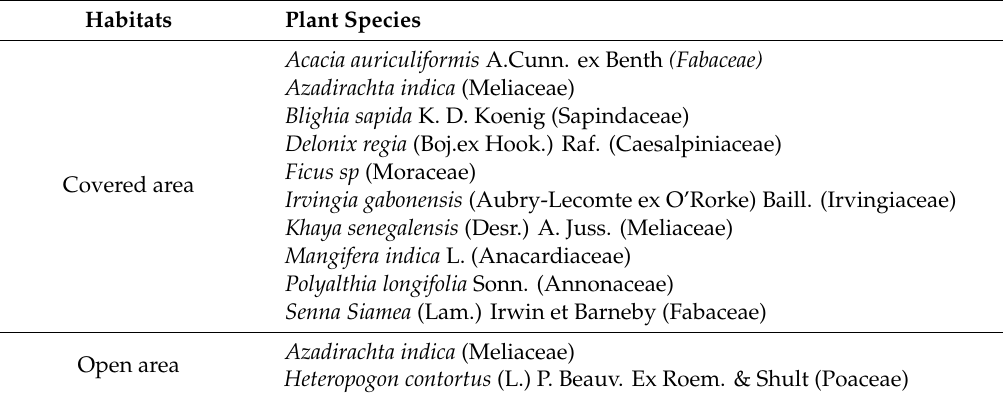
Table 1. List of encountered plants species in the study site.